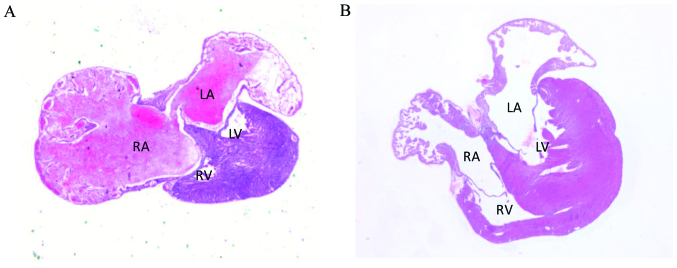
Hematoxylin and eosin (H&E) staining of coronal heart sections in the newborn mice. (A) Representative coronal heart autopsy section of neonatal heterozygous transgenic mouse. It shows an incomplete atrial septum with connective blood cells between the left and the right atria, but no obvious morphological abnormality of the myocardial cells. (B) Representative coronal heart sections of the wild-type littermates. No obvious abnormalities in cardiac tissue structure and myocardial cell morphology were observed. (A) Newborn heart of GATA4 M310V transgenic mouse. (B) Newborn heart of wild-type control mouse. LA, left atrium; RA, right atrium; LV, left ventricle; RV, right ventricle.